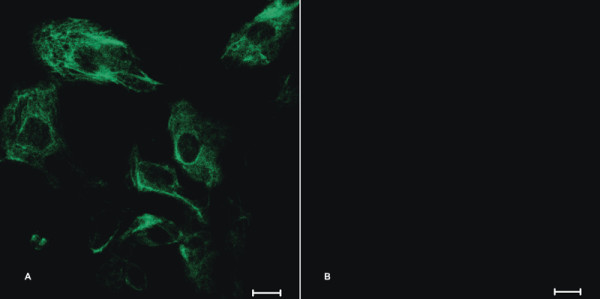
Detection of CK19 expression in A431 cells by immunofluoresence staining. A431 cells were incubated with FITC-conjugated CK-19 antibody (A) or FITC-mouse IgG1 (isotype control) (B) and analyzed the expression of CK19. The scale bar = 20 μm.